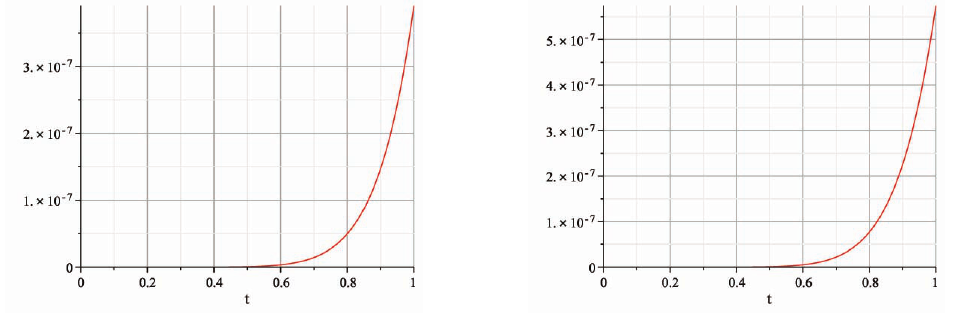
( t ) | (left) and | y ( t ) − y 10